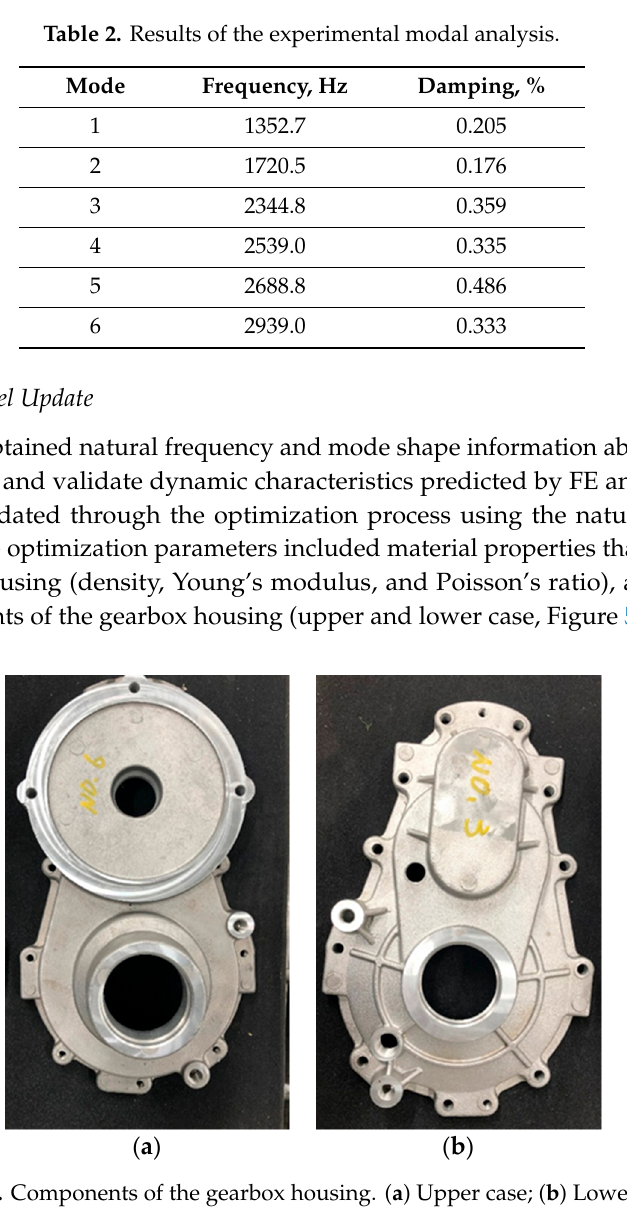
Table 3. Updated material